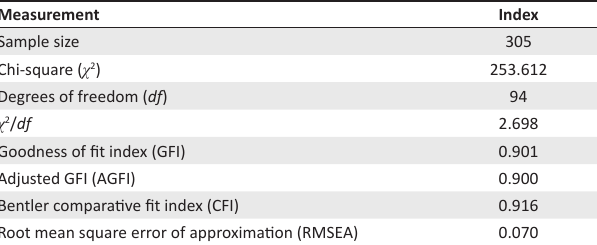
TABLE 4: Model fit indices.